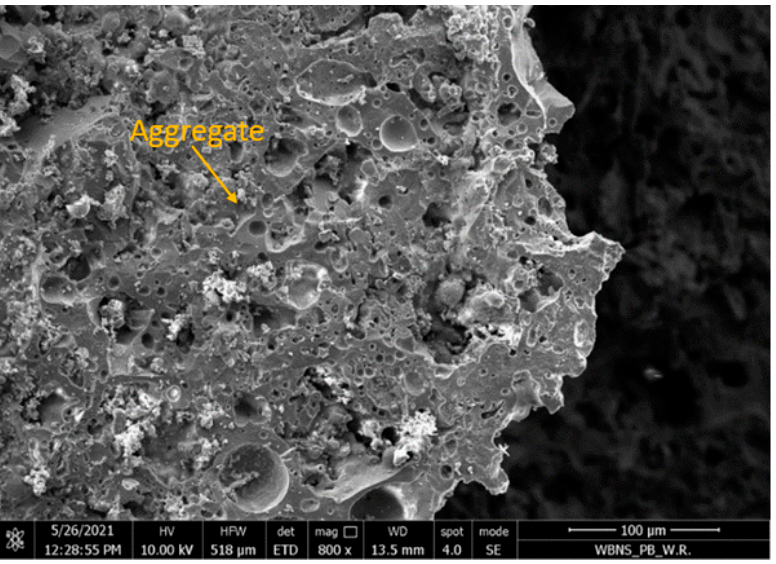
Figure 4. The porous grain structure of the artificial lightweight aggregate (magnified 800×). The microstructure of the samples consisted of a homogenous geopolymer gel matrix (Figure 5), dense packing of fly ash and slag particles, along with some minor interstitial porosity and porous aggregate (Figure 4). Silica was reported to be an abundant constituent of geopolymer matrices, and samples with greater silica content showed higher densifica- tion and lower porosity levels and were associated with a reduction in pore size and an increase in compressive strength